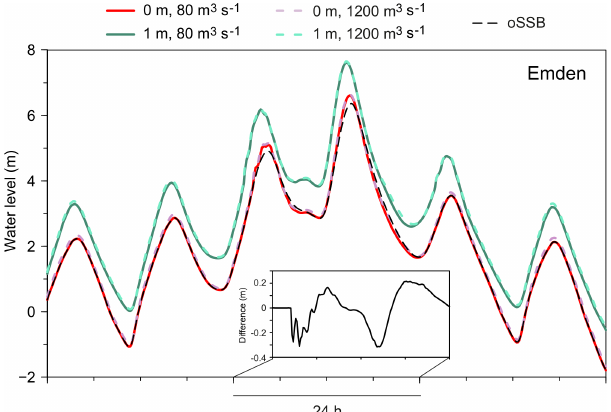
Figure 7. Highest event (EH_a): time series of the amplified water levels for the location Emden in the Ems estuary. The two solid and two dashed coloured curves display the water levels for Q equals 80 and 1200m 3 s − 1 and a SLR of 0 and 1m, respectively, and an operated storm surge barrier. As the impact of Q on the water lev- els at Emden is small, the dashed coloured curves nearly match the corresponding solid coloured curves. The dashed black curve shows water levels for an open storm surge barrier (oSSB), for Q = 80m 3 s − 1 and no SLR. The inset shows the differences be- tween the water levels for an operated (red curve in the main panel) and open (dashed black curve in the main panel) storm surge barrier over